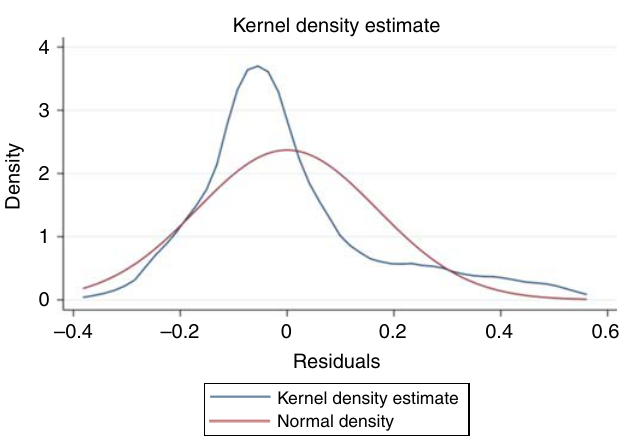
Figure A1. Kernel density